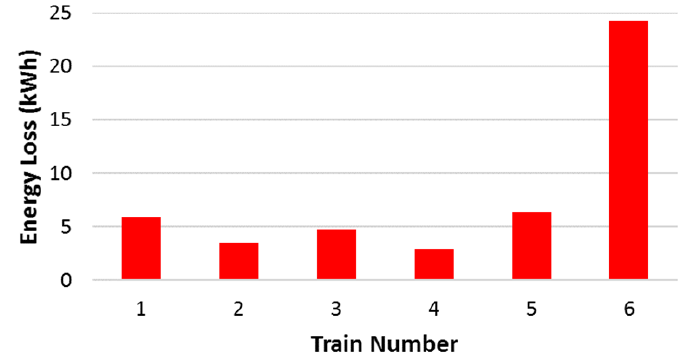
Figure 19. The dissipated energy in the braking resistors of the trains.